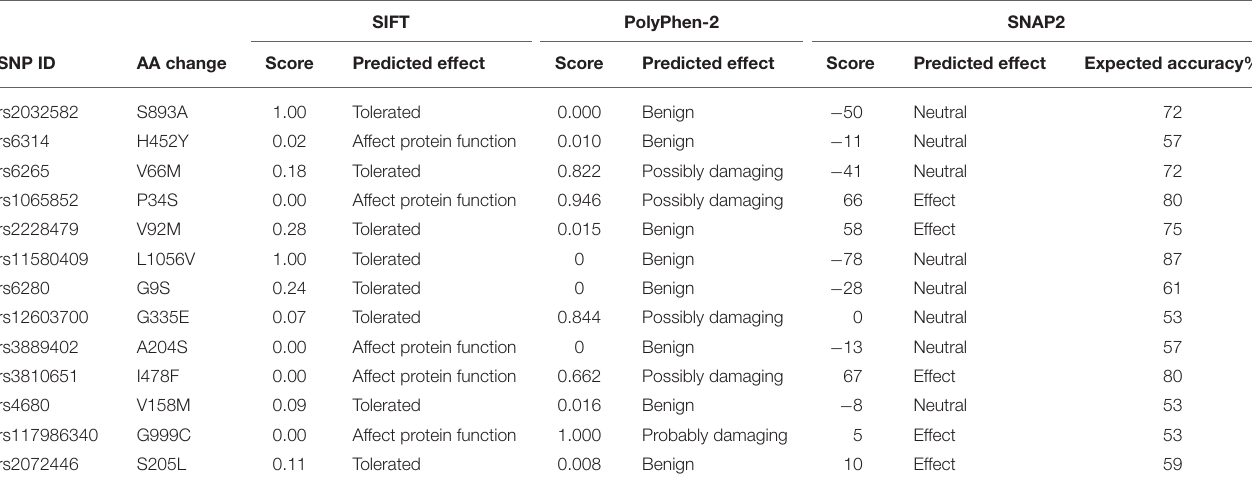
TABLE 2 | The functional analysis of nsSNPs using SIFT, PolyPhen-2, and